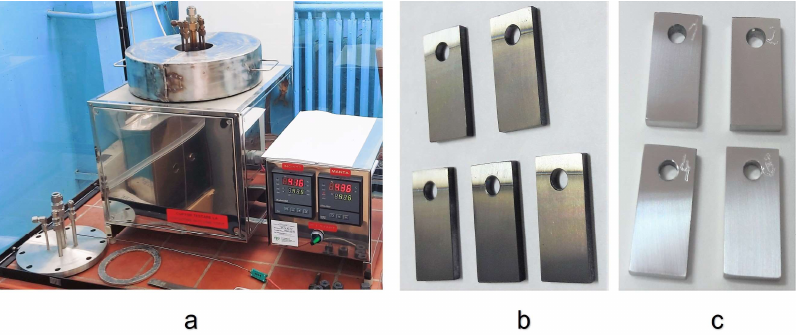
Figure 2. Installation system for corrosion tests in liquid lead: ( a ) coated ( b ) and uncoated ( c ) 316L samples before the corrosion tests.